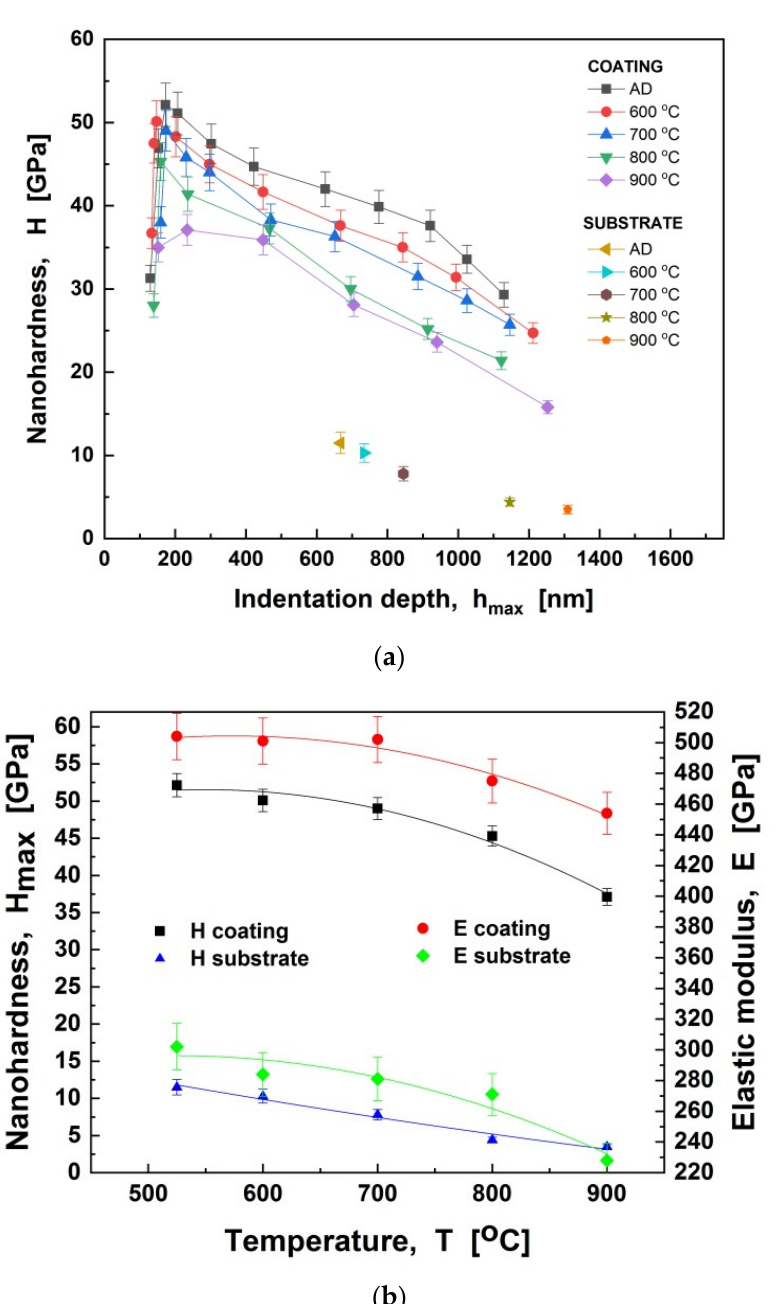
Figure 1. Mechanical properties of modulated CrAlSiN-AlSiN coating and substrate in the tempera- ture interval 600–900 ◦ C: ( a ) dependence of nanohardness on indentation depth; ( b ) dependence of nanohardness and elastic modulus on